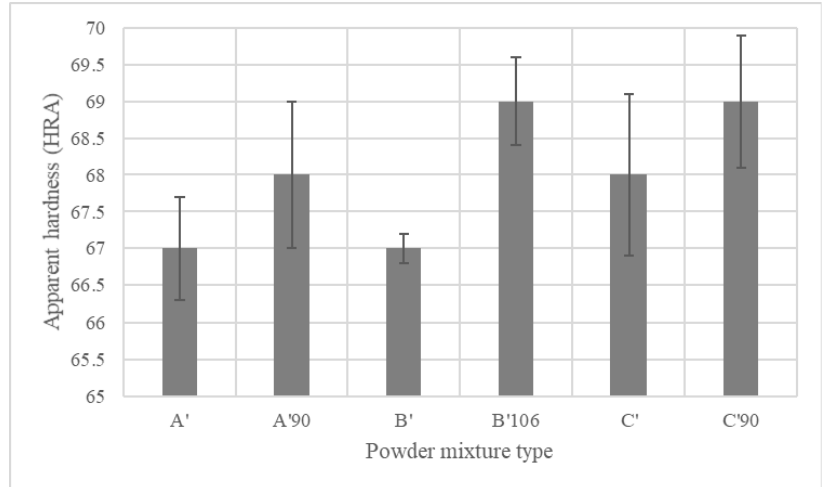
Figure 17. Apparent hardness for surface region of standard TRS samples prepared from various PMS mixtures (including 0.7 wt. % of a lubricant). Metals 2020 , 10 , 431